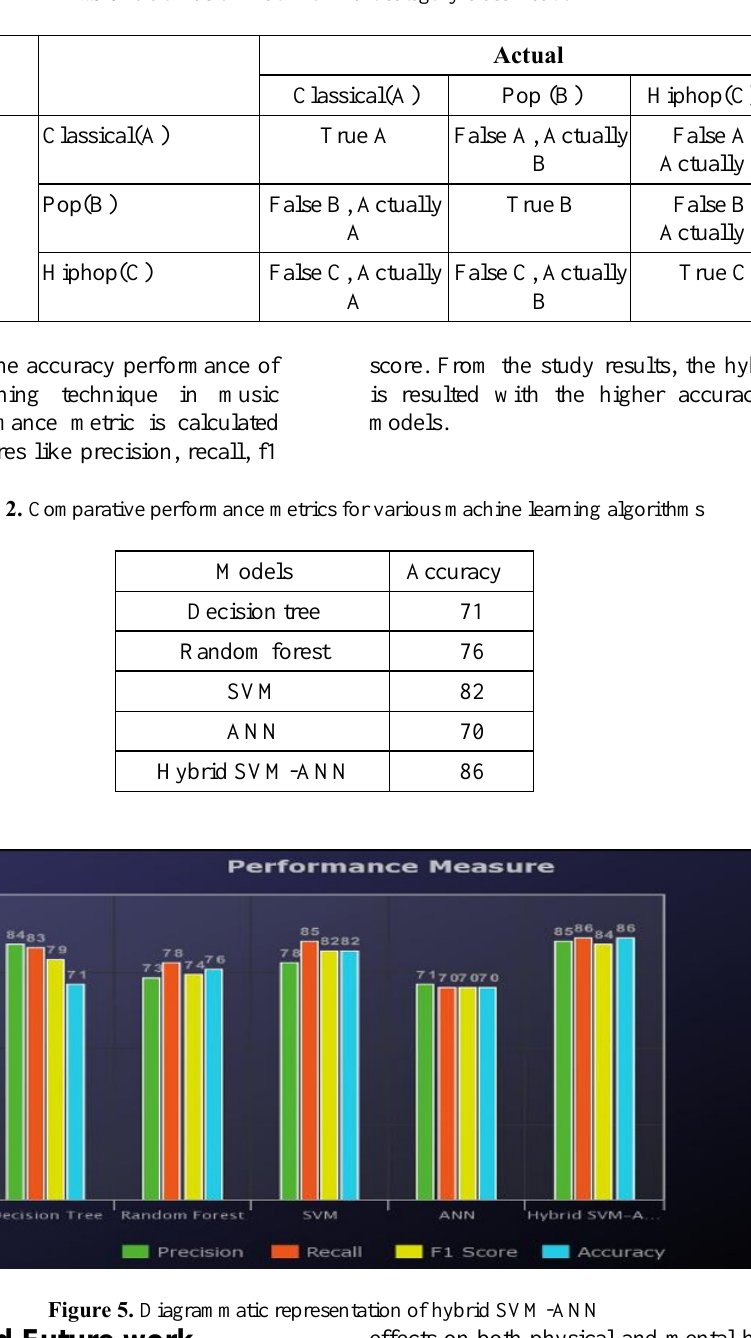
Table 1. Confusion matrix of multicategory classification